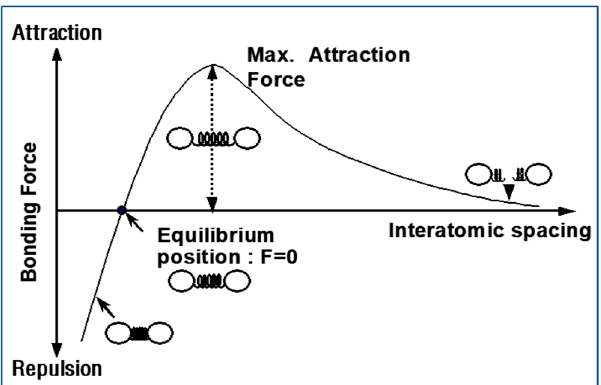
Figure 3. Schematic illustration of the bonding force dependence on spacing between atoms in the facing plates; based on [5].